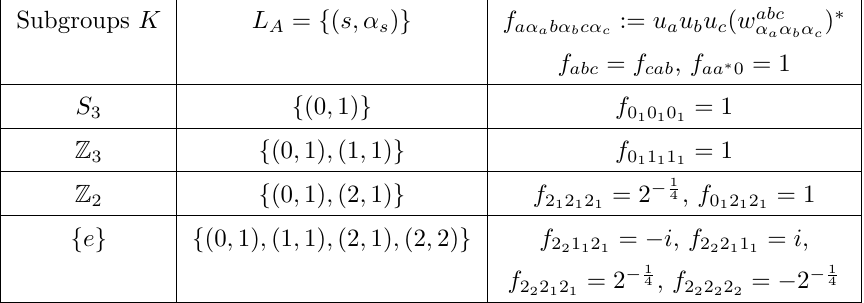
Table 3 . Four emergent Frobenius algebras A S tended QD model with G = S 3 . In the third column, only the non-vanishing symbols f are shown.